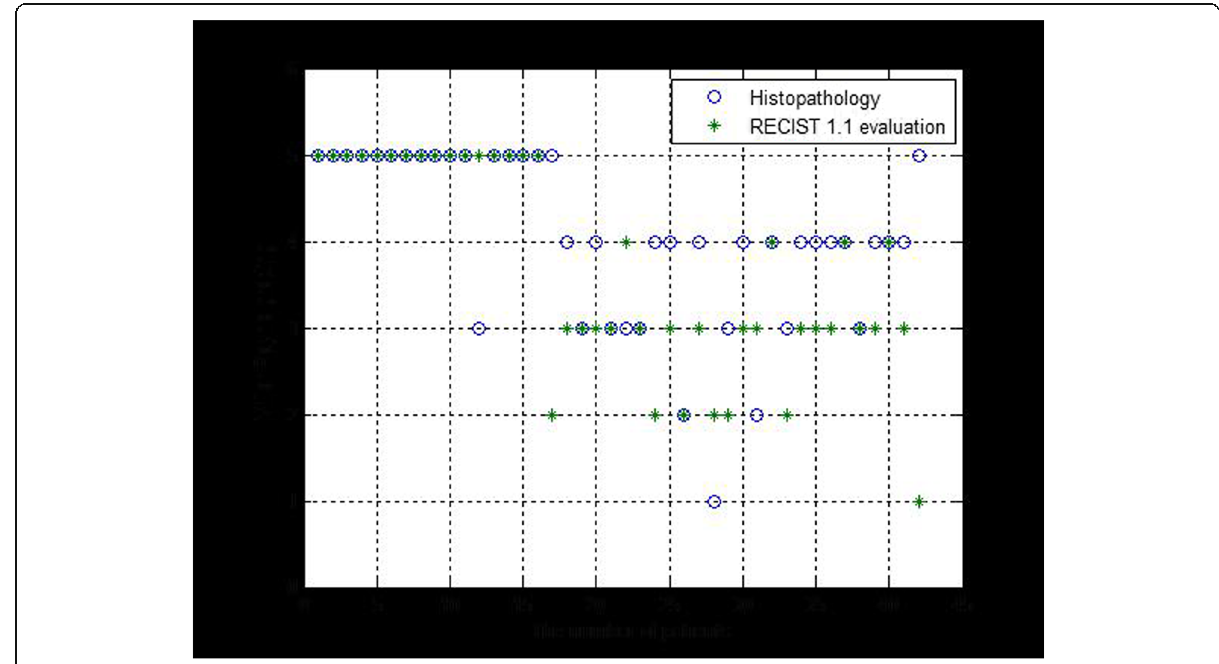
Fig. 3 The correlation between RECIST1.1 evaluation and the corresponding Miller – Payne grading